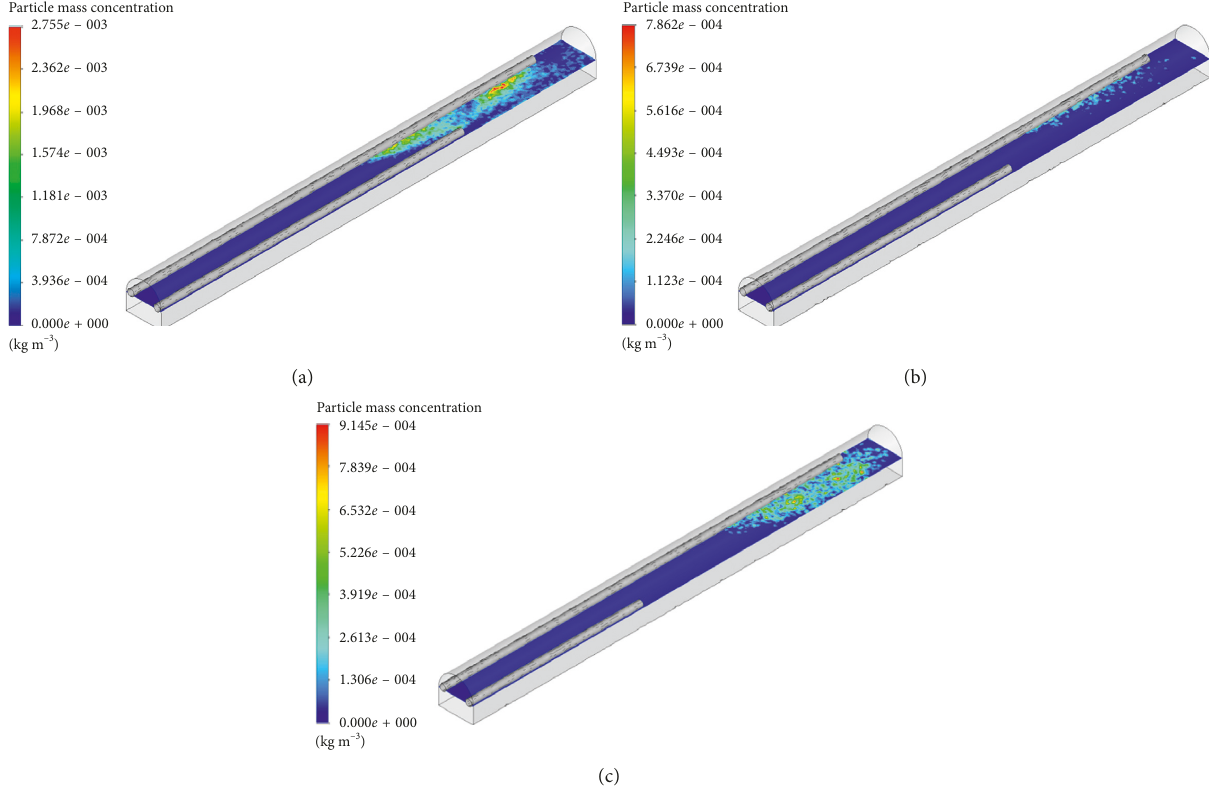
Figure 7: Influence of L on the mass concentration of dust. (a) 12 m, (b) 18 m, and (c) p - outlet